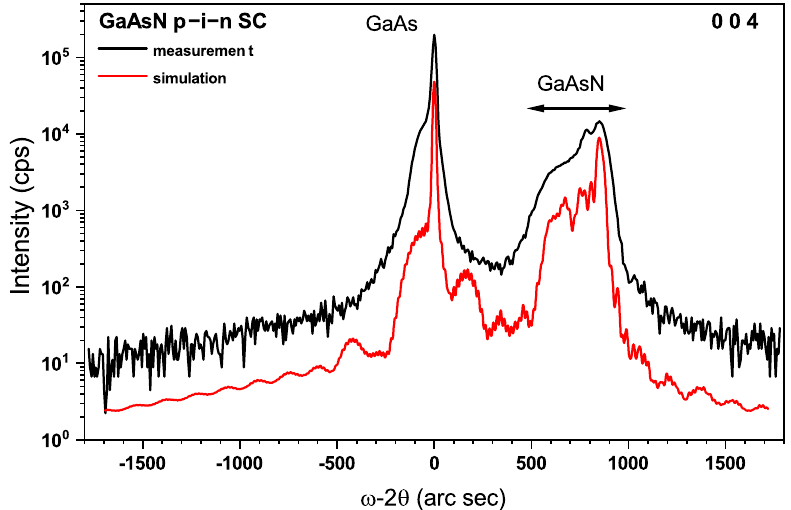
Figure 5. Diffraction curve for (004) symmetrical reflex in triple axis geometry of GaAsN p-i-n solar cell (black line) with simulation result (red